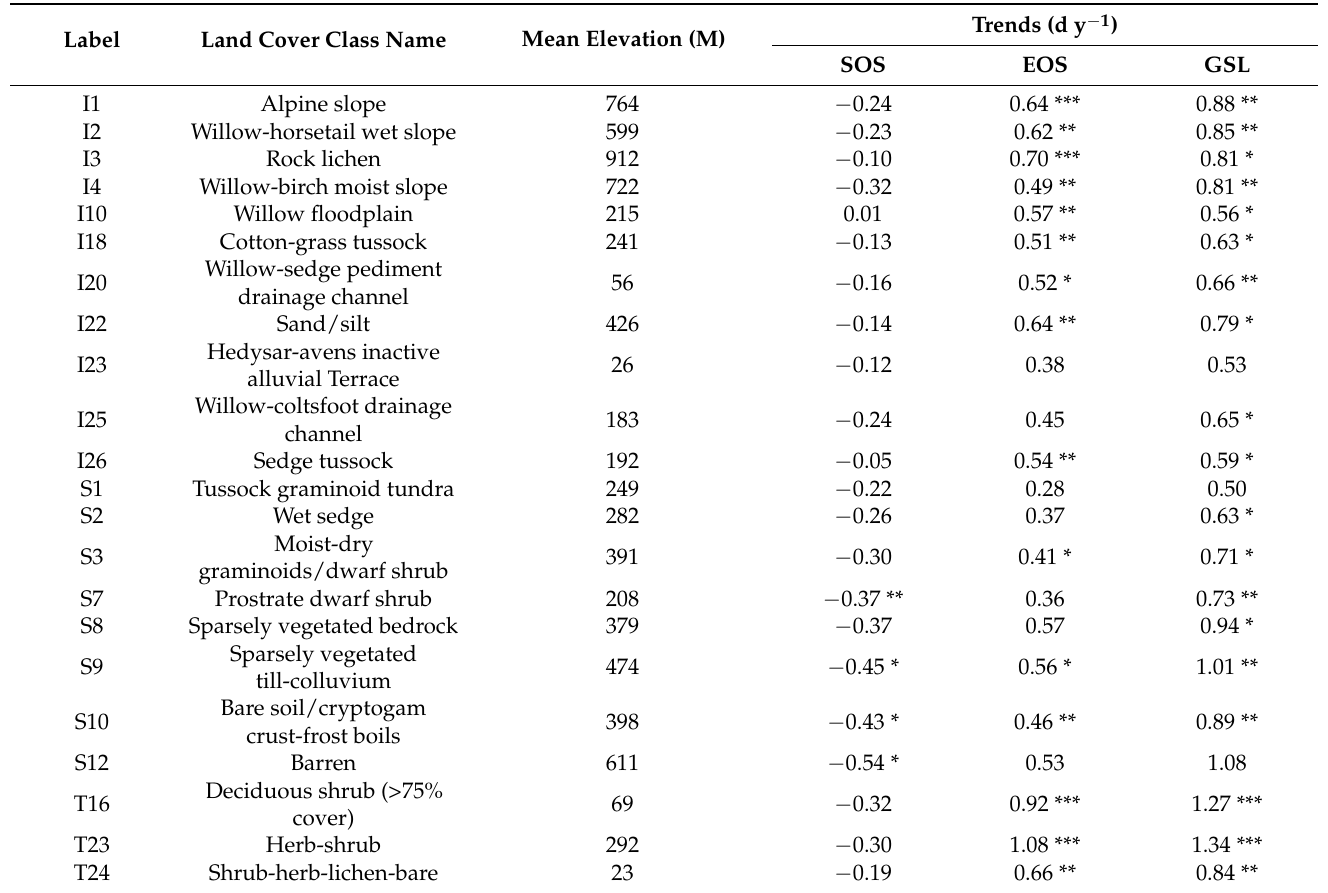
Figure 3. Example inter-annual variations and trends in SOS, EOS, and GSL during 1985–2013 for the cotton-grass tussock class in the Ivvavik National Park. Error bars show one standard estimation errors in SOS, EOS, or GSL. Statistics for these trends are listed in Table 2. Table 2. Tundra or wetland class in the five study areas: Ivvavik (denoted with I), the Torgnat Mountains (T), Sirmilik (S), and Wupask (W) National Parks, and the Bathurst (B) caribou range. Also included are long-term trends (i.e., slopes) of SOS, EOS, and GSL during 1985–2013 as well as mean elevation of each class. The superscripts of *, **, and *** stand for significant at the 90%, 95%, and 99% confidence level, respectively.